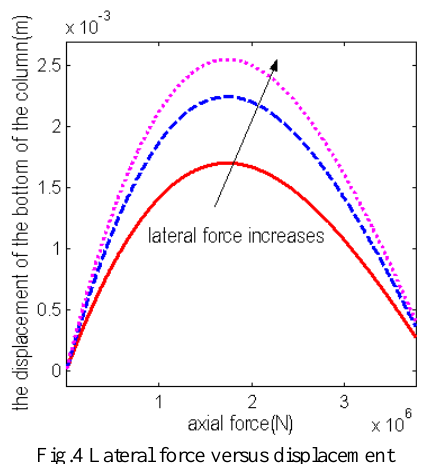
Fig.2 Lateral force versus displacement